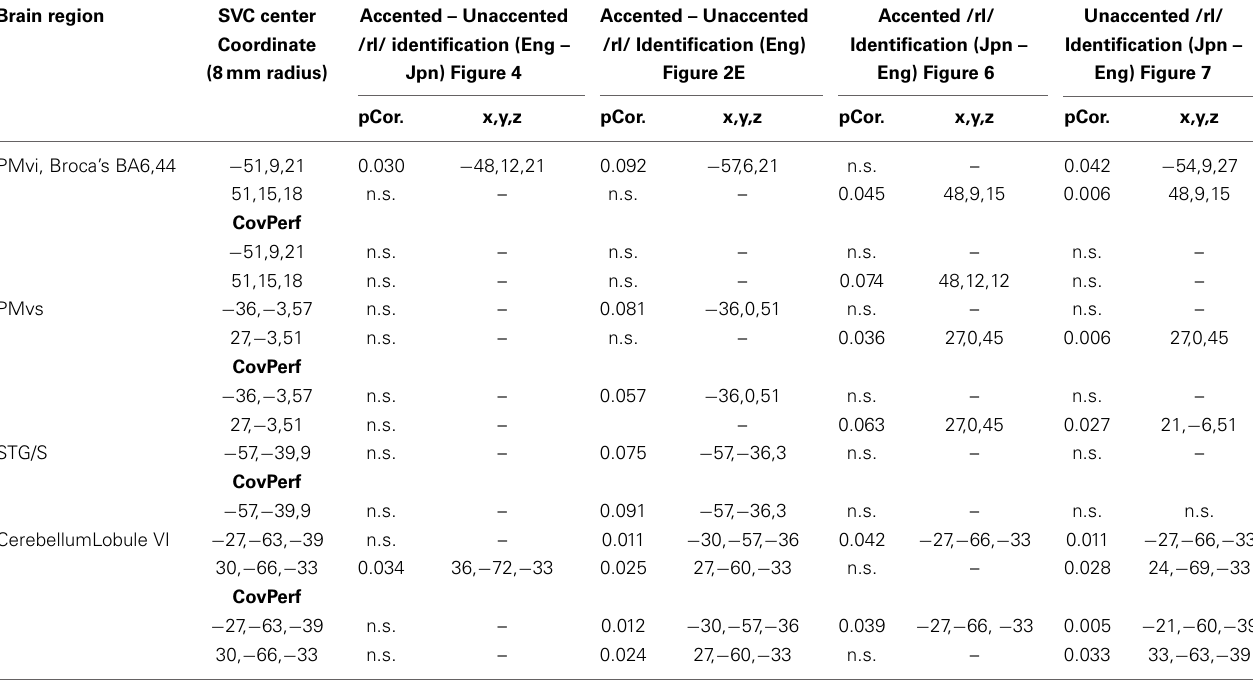
Table showing results of small volume correction analysis (p < 0.05) for multiple comparisons for selected contrasts within regions of interest using MNI coordinates specified in Callan et al. (2004a) as the seed voxels. The first set of results is for the original analysis. The second set of results, under the heading of CovPerf, is for the analysis in which phonetic identification performance is used as a covariate of non-interest. SVC, Small volume correction; ROI, Region of Interest; BA, Brodmann area; PMvi, Premotor cortex ventral inferior; PMvs, Premotor cortex ventral superior. n.s., Not significant at p < 0.05 corrected. pCor., p corrected for multiple comparisons within the SVC small volume corrected region of interest. Negative × MNI coordinates denote left hemisphere and positive × values denote right hemisphere activity.